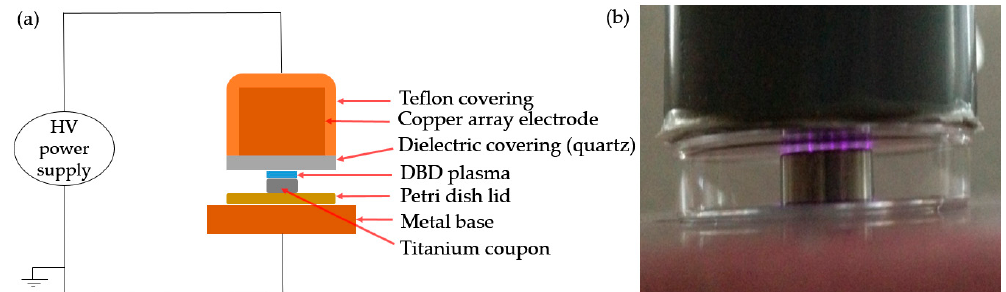
Figure 4. Schematic diagram and photograph of the regular DBD plasma setup. ( a ) demonstrates the schematic diagram of the regular DBD plasma and ( b ) shows the actual experimental setup of DBD plasma [70].